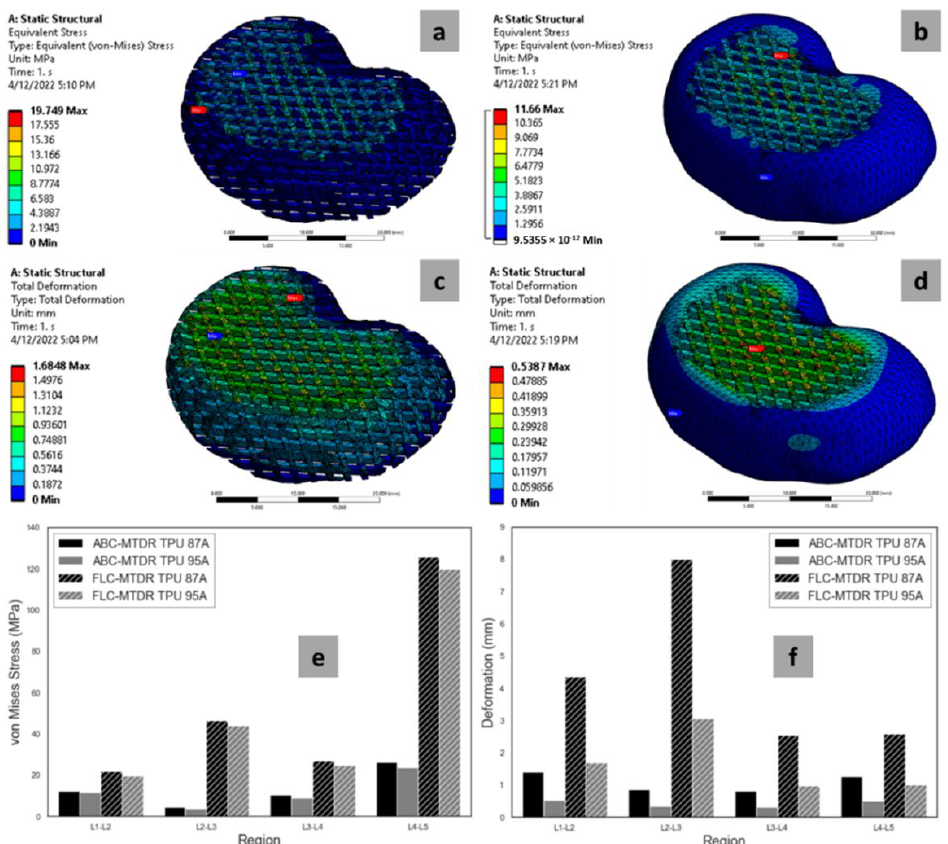
Figure 10. Representative stress profiles of FLC-MTDR ( a ) and ABC-MTDR ( b ). Representative deformation profiles of FLC-MTDR ( c ) and ABC-MTDR ( d ). Graphs of von Mises stresses ( e ) and deformations ( f ) resulting from the FEA.